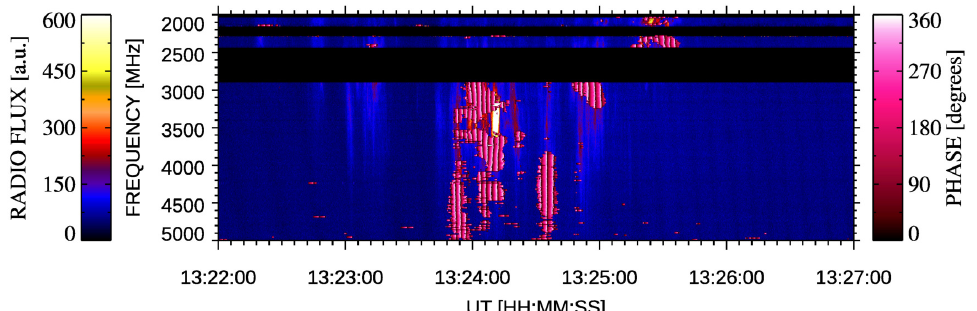
Figure 5. The type III bursts observed on 2 April 2022 in the 2000–5000MHz range in the 13:22:00– 13:27:00 UT time interval: the first panel (from top to bottom ): the radio spectrum observed by the Ondˇrejov radiospectrograph; second panel: histogram of the significant periods detected by the wavelet transform (cross-hatched bands, separated by vertical lines, mark intervals of periods in bottom phase maps); and bottom four panels: the phase maps (pink areas with the black lines showing the zero phase of oscillations) overplotted on the radio spectrum for periods detected in the ranges of 7.6–12.2, 5.2–7.5, 3.4–5.1 and 1.9–3.3 s. The significance level of these phase maps is 99%.